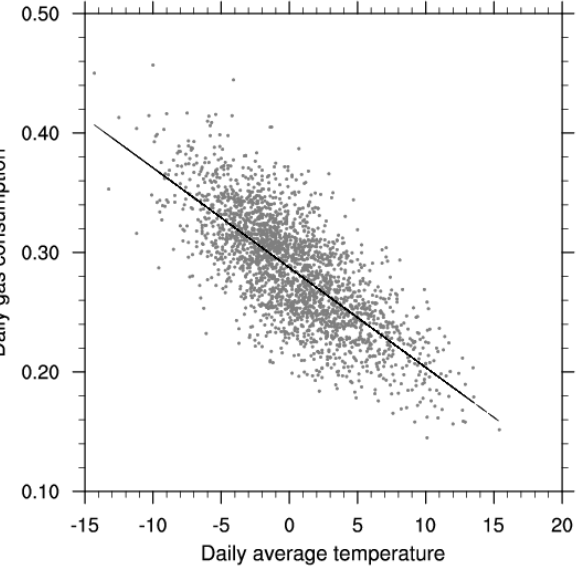
Figure 2. Scatterplot of the daily natural gas consumption normalized by GDP and daily average temperature (unit: °C) during heating season for the period of 2002–2021 in Beijing. The solid line denotes the linear fitting of the dots.